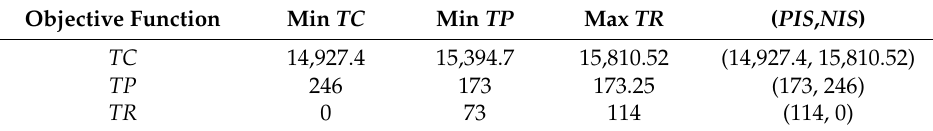
Table 4. The positive ideal solution (PIS) and negative ideal solution (NIS) under each objective function. TC : total cost for the project; TP : total duration time for the project; TR : total crash time for the